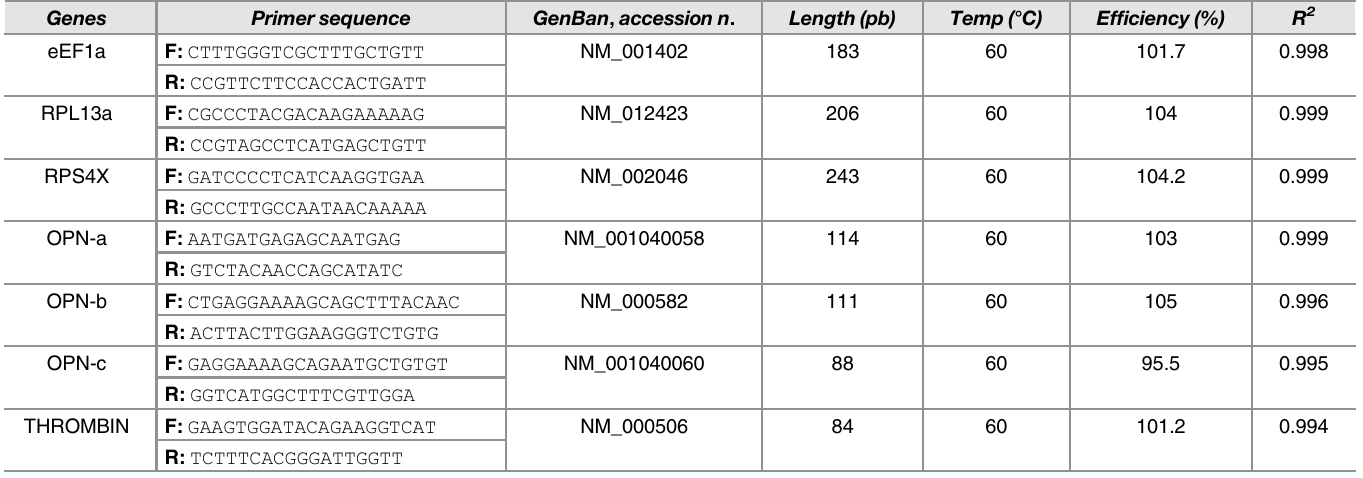
Table 2. Primer sequence details of the analyzed